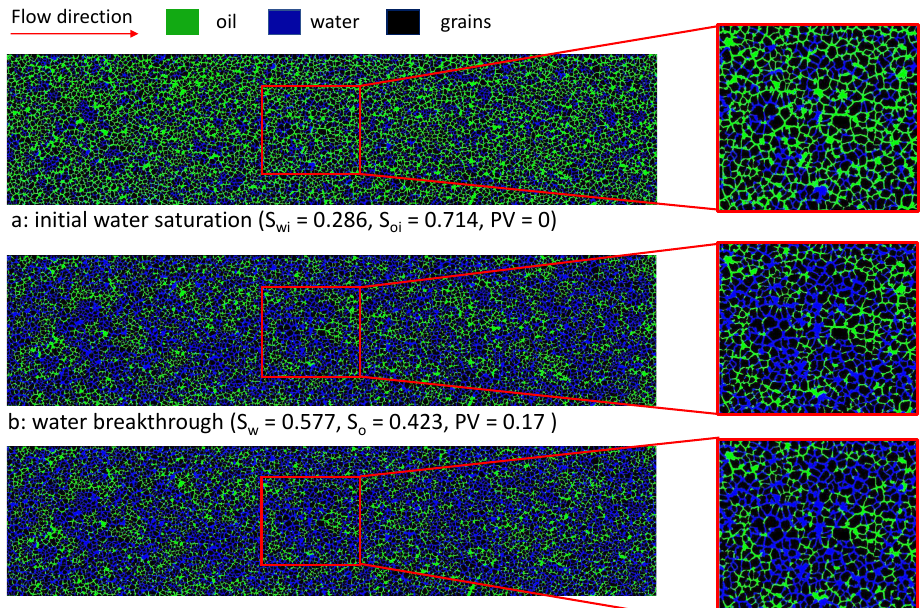
Figure 5. Development of the water saturation as a function of PV